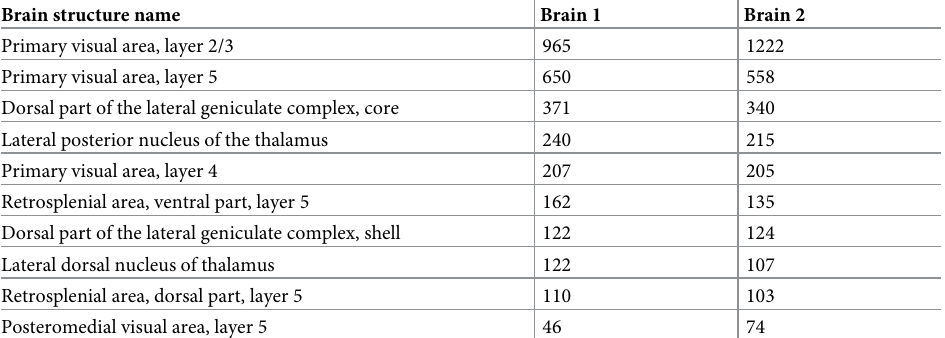
Table 3. Total number of cells in each region, per brain, projecting to layer 2/3 neurons in primary visual cortex. Ten regions with the greatest number of cells across both brains shown.